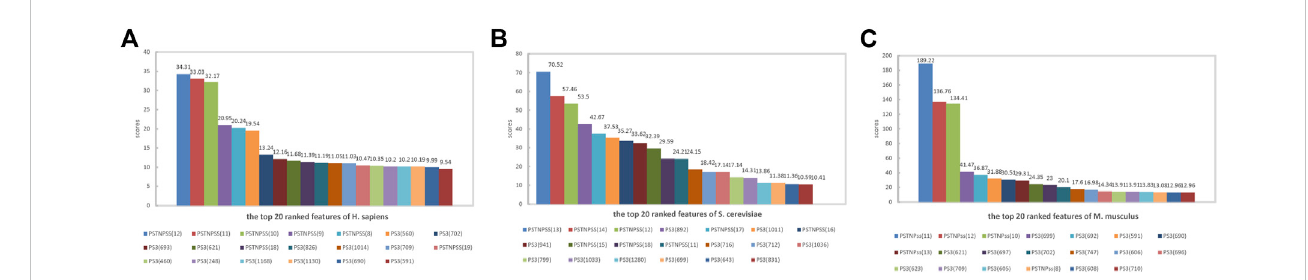
FIGURE 6 Top 20 features of PseU-ST ranked according to feature scores for predicting RNA Ψ sites of (A) H. sapiens , (B) S. cerevisiae , and (C) M. musculus